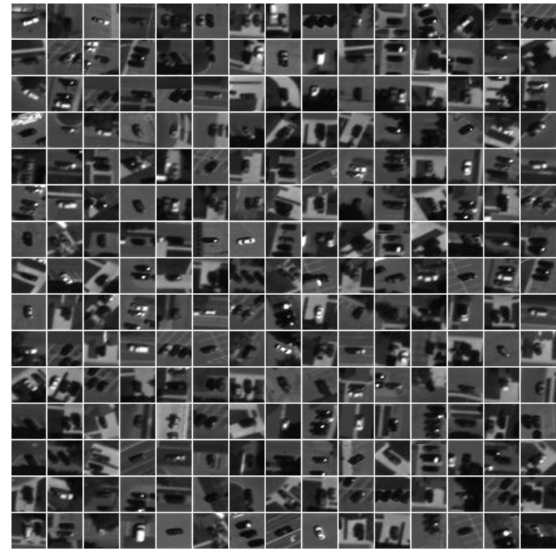
Figure 3. The vehicles in UNICORN 2008 dataset.